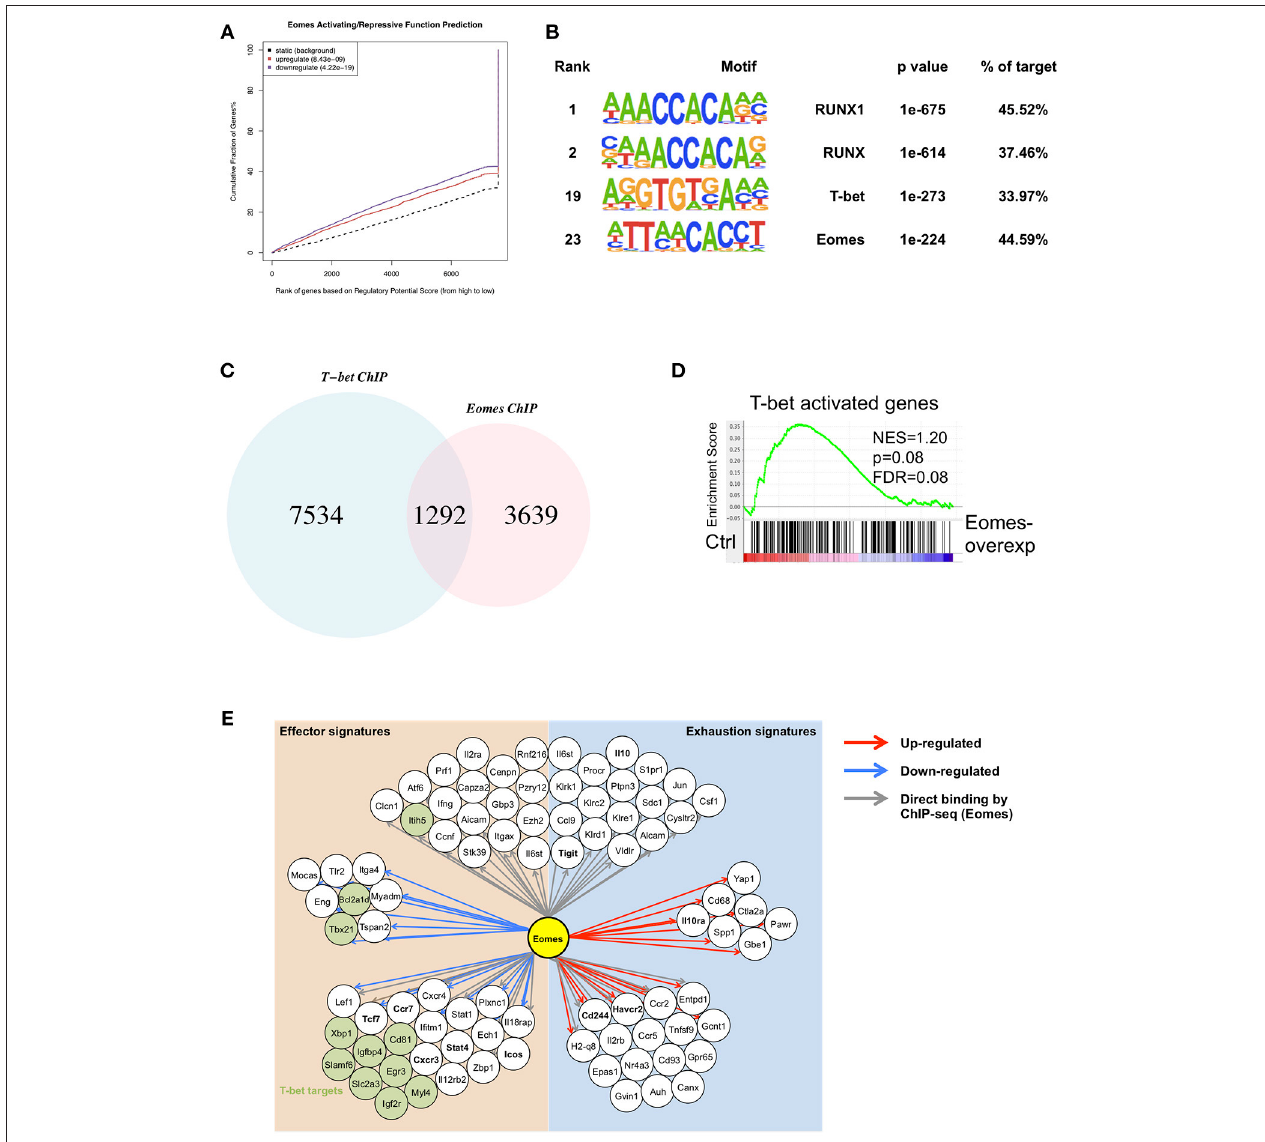
FIGURE 6 | Integrative analysis of ChIPseq and RNAseq data. (A) BETA analysis predicting activating/repressive function of Eomes in CD8 + T cells. p -values represent the significance of the up or down group calculated by the Kolmogorov-Smirnov test. (B) Transcription factor motif enrichment in ChIPseq peaks using HOMER. (C) Venn diagram showing overlapping peaks between Eomes-binding sites and T-bet-binding sites identified by ChIPseq. (D) GSEA of T-bet-activated genes. Genes from the left to right of the rank-ordered list are enriched in control and Eomes-overexpressing OT-I cells, respectively. (E) Network model based on RNAseq data of Eomes-overexpressing vs. control OT-I cells and Eomes binding events (ChIPseq data for Eomes). Red arrows designate genes up-regulated by Eomes, blue arrows designate genes down-regulated by Eomes, and gray arrows denote Eomes-binding events on associated genomic